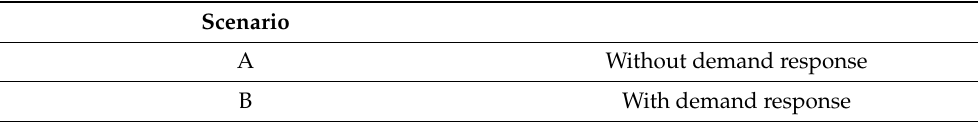
Table 2. Two scenarios without and with